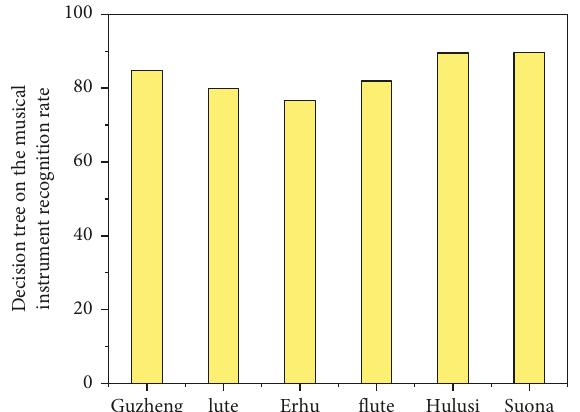
Figure 8: Recognition rate of mixed samples of Chinese traditional musical instruments classified by a decision tree. Table 8: Recognition and classification accuracy of Chinese tra- ditional musical instruments based on DBN combined with softmax algorithm in different training sets. Proportion of labeled samples in all DBN combined with training samples softmax (%) 1/6